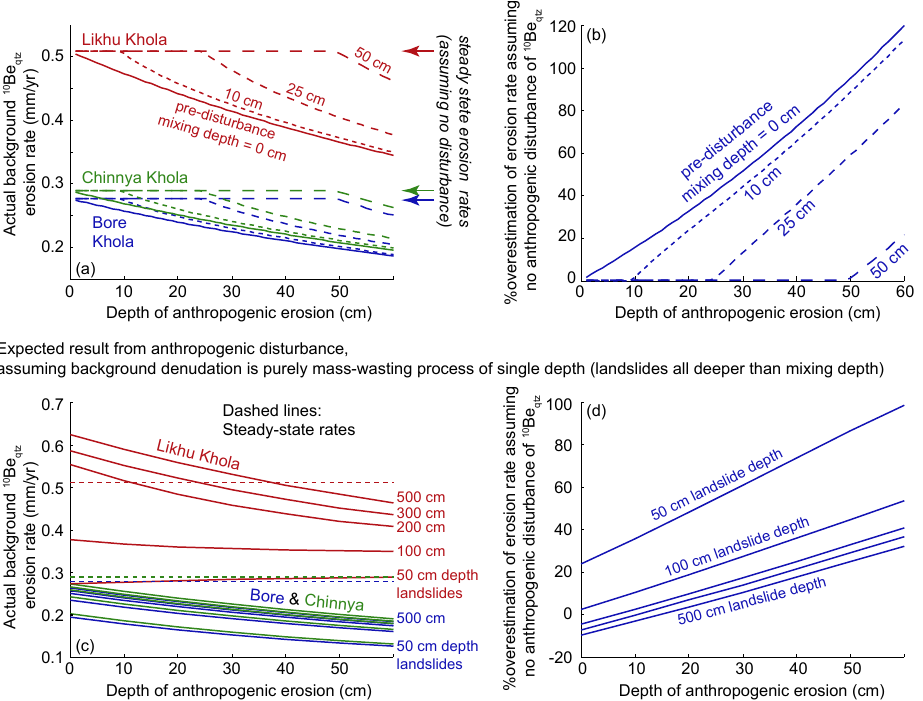
Figure A2. Results of model testing sensitivity of denudation rates estimates to agricultural reworking. Effect of anthropogenic disturbance on long-term erosion rates inferred from 10 Be qtz , as a result of increased erosion removing soil from below the surface. Panels (a) and (b) show the case for steady-state denudation prior to disturbance, and (c) and (d) show the case for mass wasting denudation. In (a) and (b) , the effect of disturbance depends on the depth of the mixed layer relative to the depth of agricultural reworking. In (c) and (d) , mixing is not considered explicitly, for simplicity. The implied erosion rate at z e = 0 in (c) and (d) differs from the steady-state erosion rate, because of the influence of mass wasting depth and recurrence interval on inferred rates (cf. Fig. A1). When the depth of perturbation is lower than the depth of natural mixing, steady-state denudation rates (from Eq. 1) yield representative long-term rates (e.g., horizontal portions of the lines in a, b ). When the depth of perturbation exceeds the depth of mixing, the enhanced supply of shielded material with low 10 Be concentrations biases the river sediment and means that rates calculated assuming steady state would overestimate the actual long-term denudation rate in the absence of anthropogenic activity (by a proportion shown in panel b